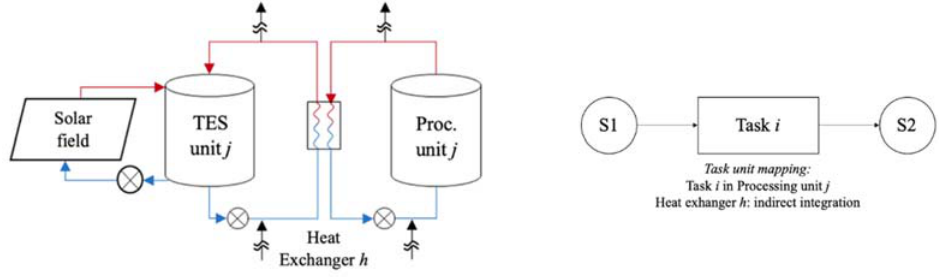
Figure 2. Thermal energy storage (TES) system and state-task network (STN) representation.